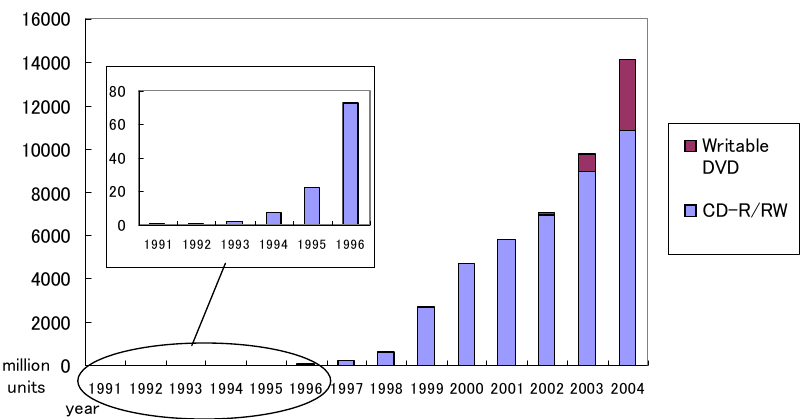
Figure 7. Trend in writable optical storage media